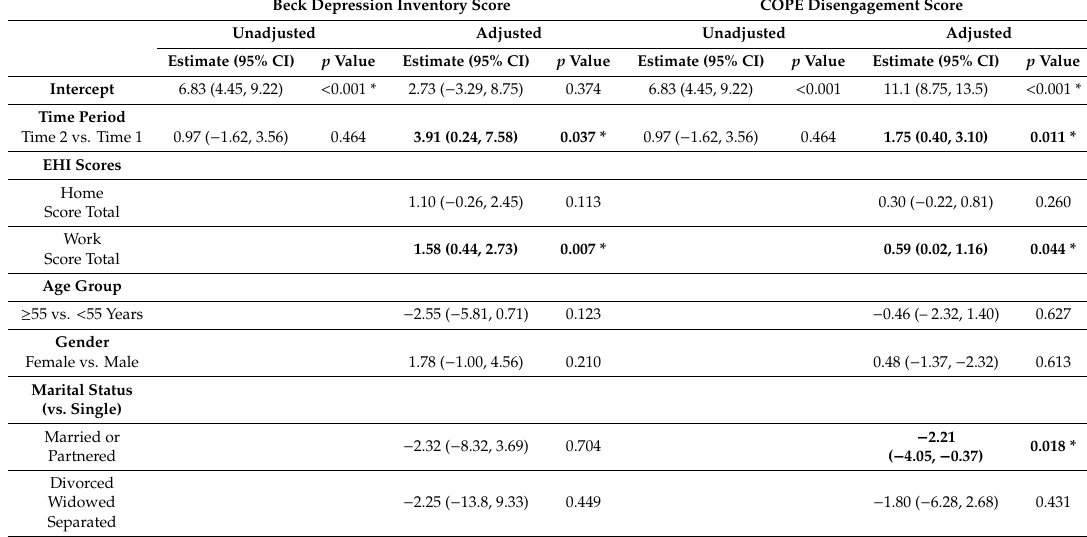
Table 4. Unadjusted and adjusted Generalized Estimating Equation (GEE) models assessing change in BDI and COPE disengagement scores across the study period. Beck Depression Inventory Score COPE Disengagement Score Unadjusted Adjusted Unadjusted